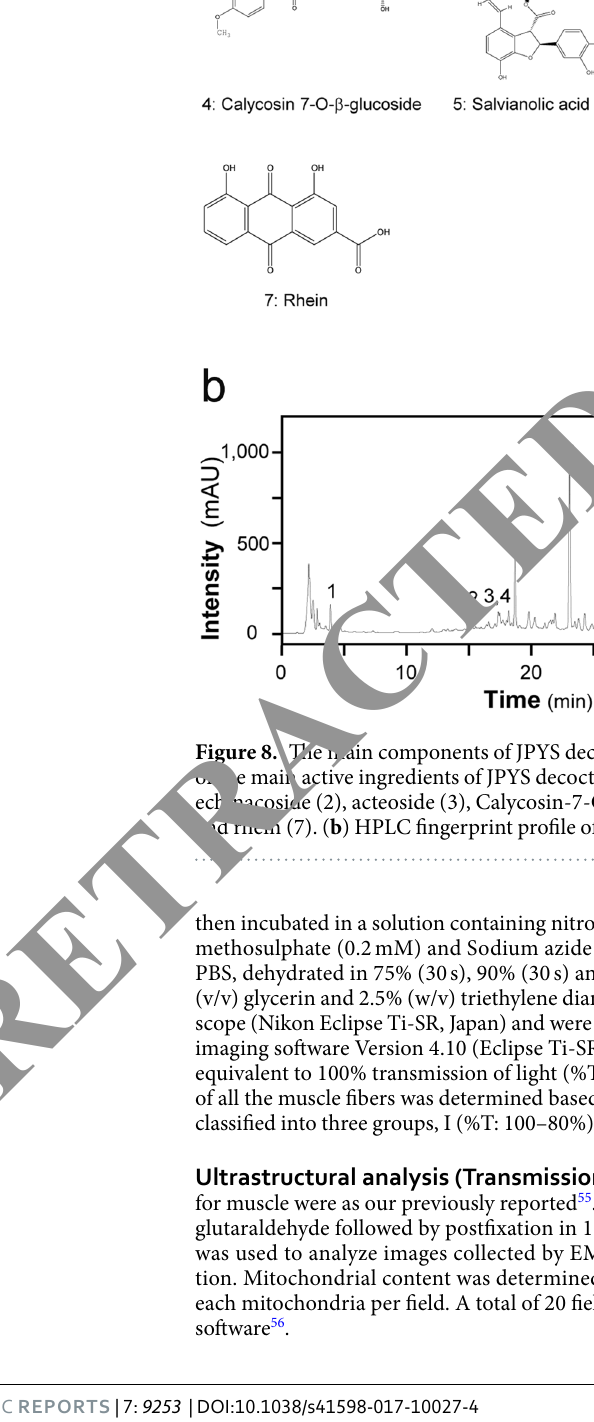
9 SCieNTifiC REPORTS | 7: 9253 | DOI:10.1038/s41598-017-10027-4